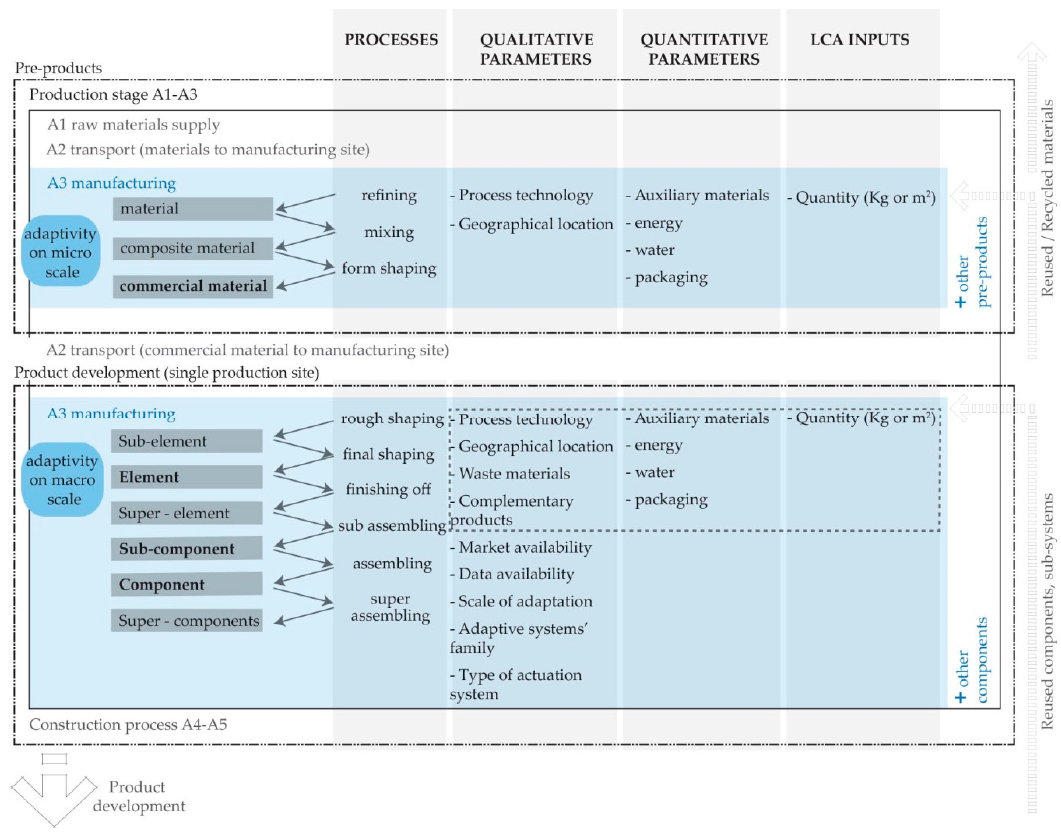
Figure 7. Mapping of LCA parameters for AM-components in the phase